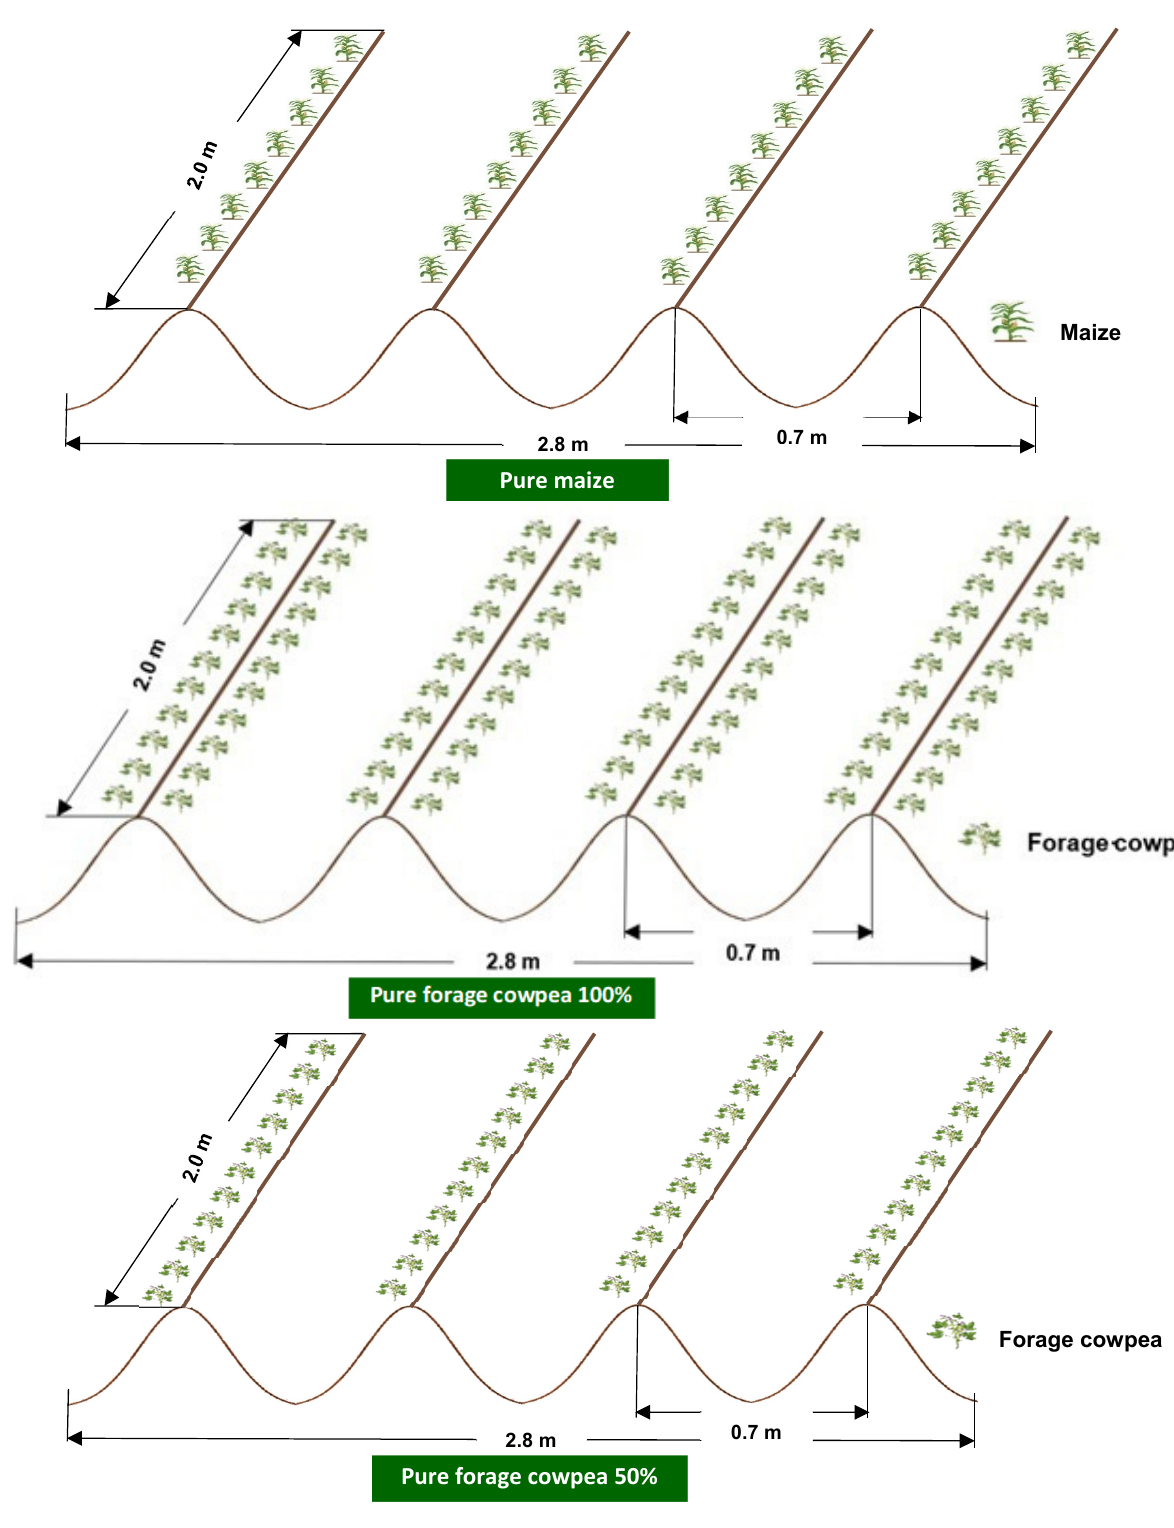
Figure 3. Experimental plot design illustrating the sowing pattern of the pure maize (100%) and pure forage cowpea (100 and 50%).